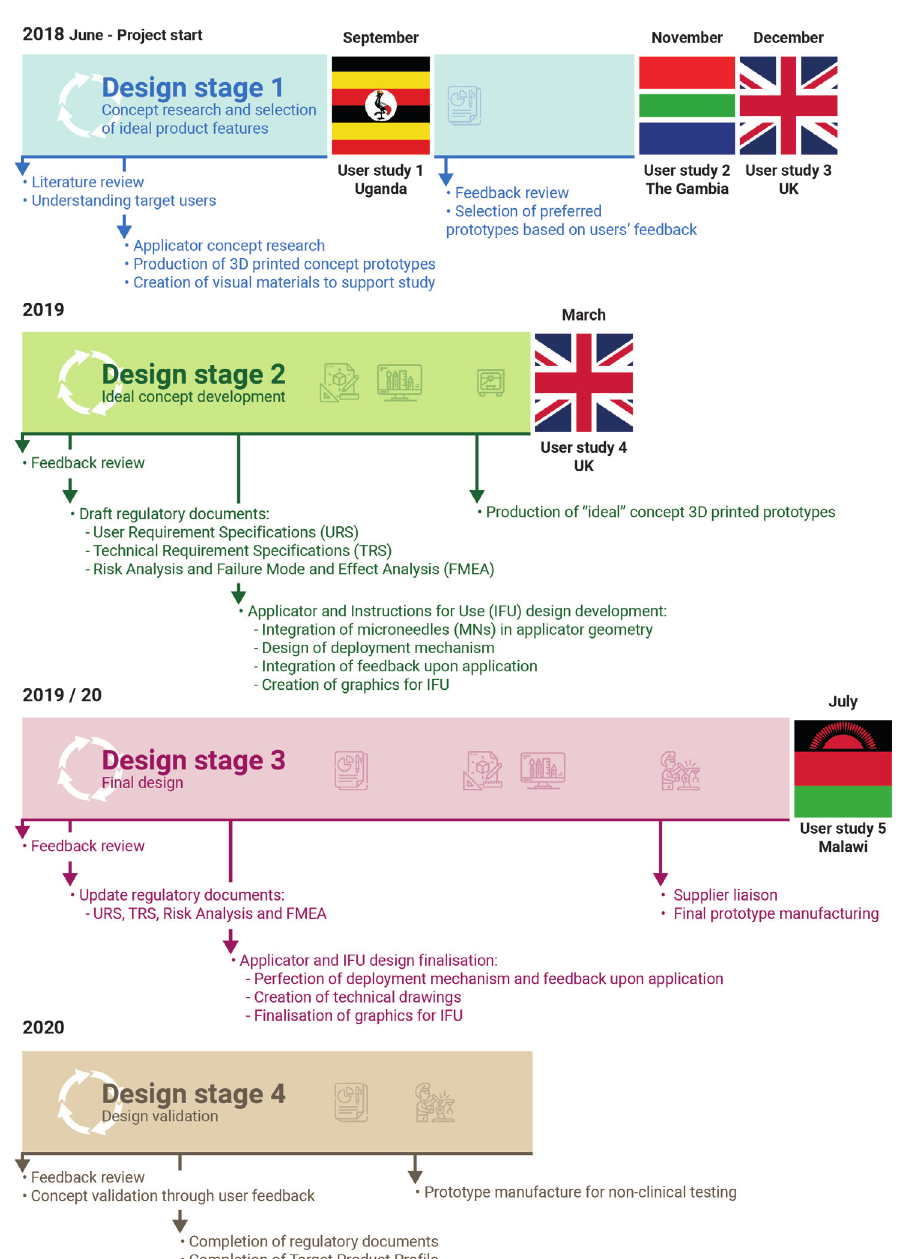
Figure 1. Project timeline. Following the HCD approach schematised in Figure 2, the project started with concept research based around the published literature on the unmet need for contraception in LMICs. Multiple prototypes covering a wide range of desirable features for a contraceptive product were produced and evaluated by potential stakeholders in LMICs. Participant feedback helped refine the product according to stakeholders’ preferences and consolidate the final product design. This was then validated through a final users’ evaluation prior to pre-clinical